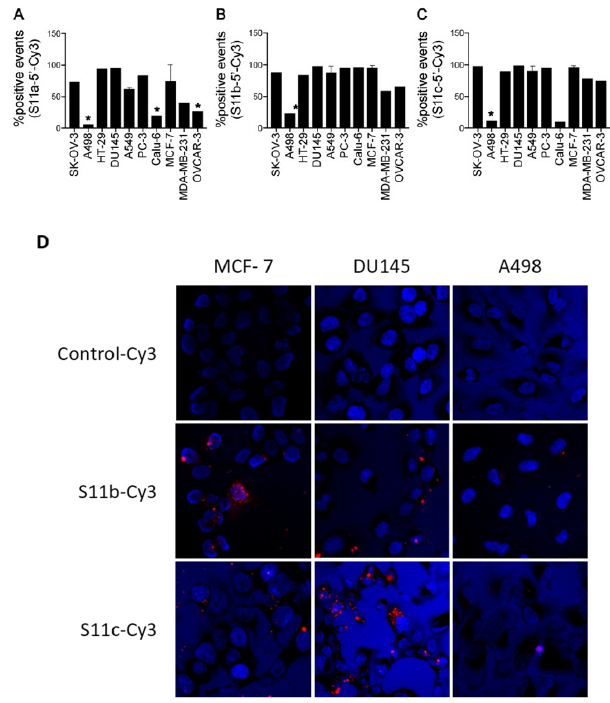
Figure 5. ( A – C ) Percentage of positive events of MUC1/Y in SK-OV-3, A498, HT-29, DU145, A549, PC-3, Calu-6, MCF-7, MDA-MB-231 and OVCAR-3 using the aptamers ( A ) S11a, ( B ) S11b, and ( C ) S11c. ( D ) Representative immunofluorescence of MCF-7, DU145, Calu-6, and A498 cells stained with control-Cy3 (aptamer SP68; selected against a different/non-MUC1 tumour marker peptide), S11a-Cy3 or S11b-Cy3,* p < 0.05.